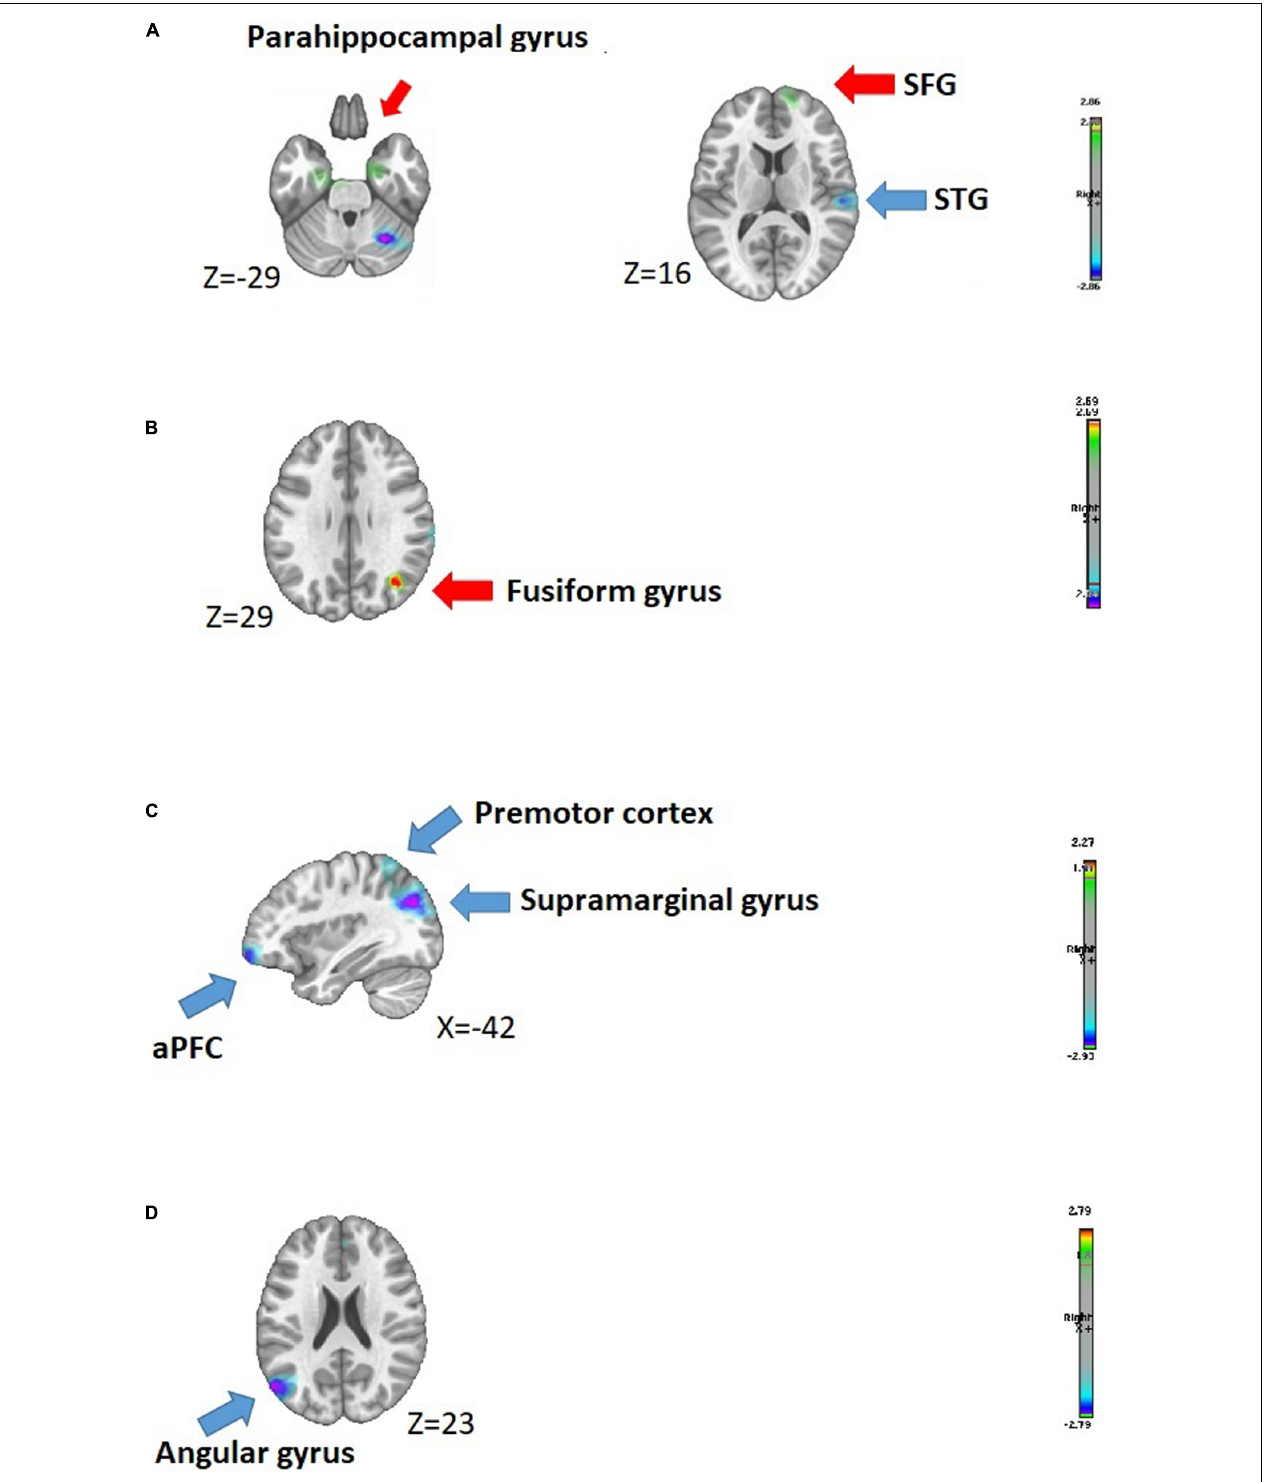
FIGURE 5 | Source localizations analysis. (A,B) Inverse solutions conducted for non-dominant (Dominance = 1) avatars, measured in evoked potentials N170 and LPP, respectively. (C,D) Inverse solutions conducted for relatively trustworthy (Trust = 4) avatars, measured in evoked potentials N170 and LPP, respectively.